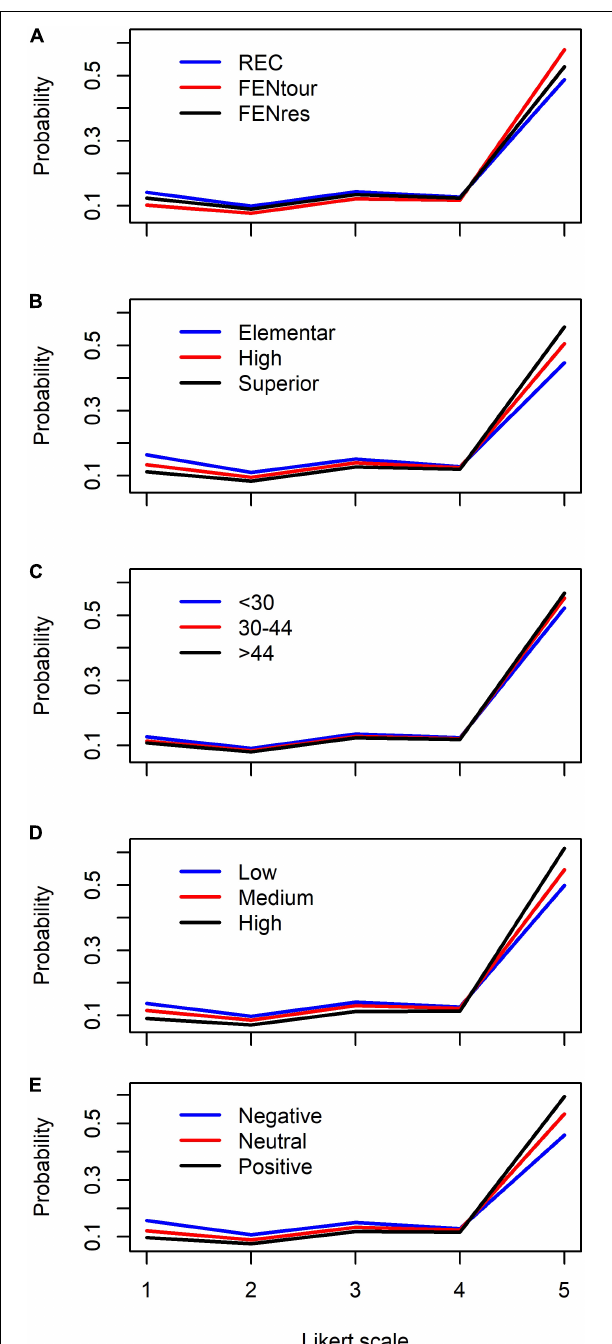
FIGURE 1 | Probability distribution of a 5-level Likert scale of knowledge about sharks across (A) sampling treatments (i.e., Recife – REC, tourists of Fernando de Noronha – FENtour, and residents at Fernando de Noronha – FENres), (B) education level (i.e., elementary, high and superior education), (C) age classes (i.e., < 30, 30–44, and > 44 years old), (D) affinity for nature classes (i.e., low, medium, and high affinity for nature), and (E) types of prejudice toward sharks (i.e., negative, neutral, and positive prejudice), assessed with a Likert-based ordered logistic regression model. The Likert scale spans from 1 through 5, with 5 being the most positive/correct option. Confidence intervals were not included for clarity